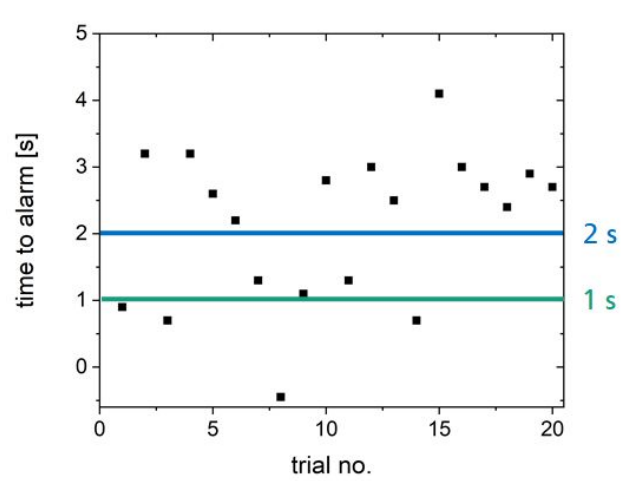
Fig. 8. 252 Cf with 14 200 n/s in 20.8 cm distance and 0.42 m/s. 2 s is the criterion for the IEC test, 1 s is the criterion for the ANSI RIID test.